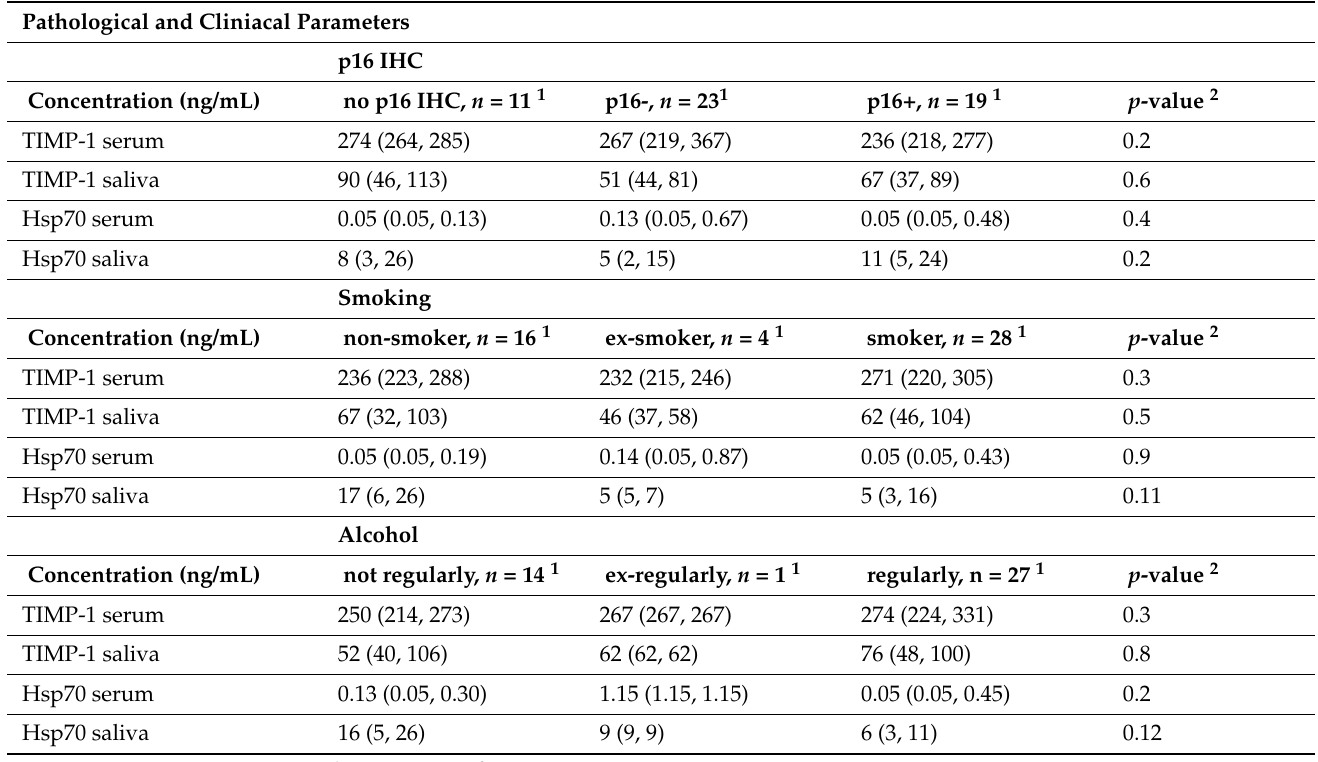
Table 4. Protein concentration and pathological and clinical parameters of HNSCC patient pretreat- ment samples (n =